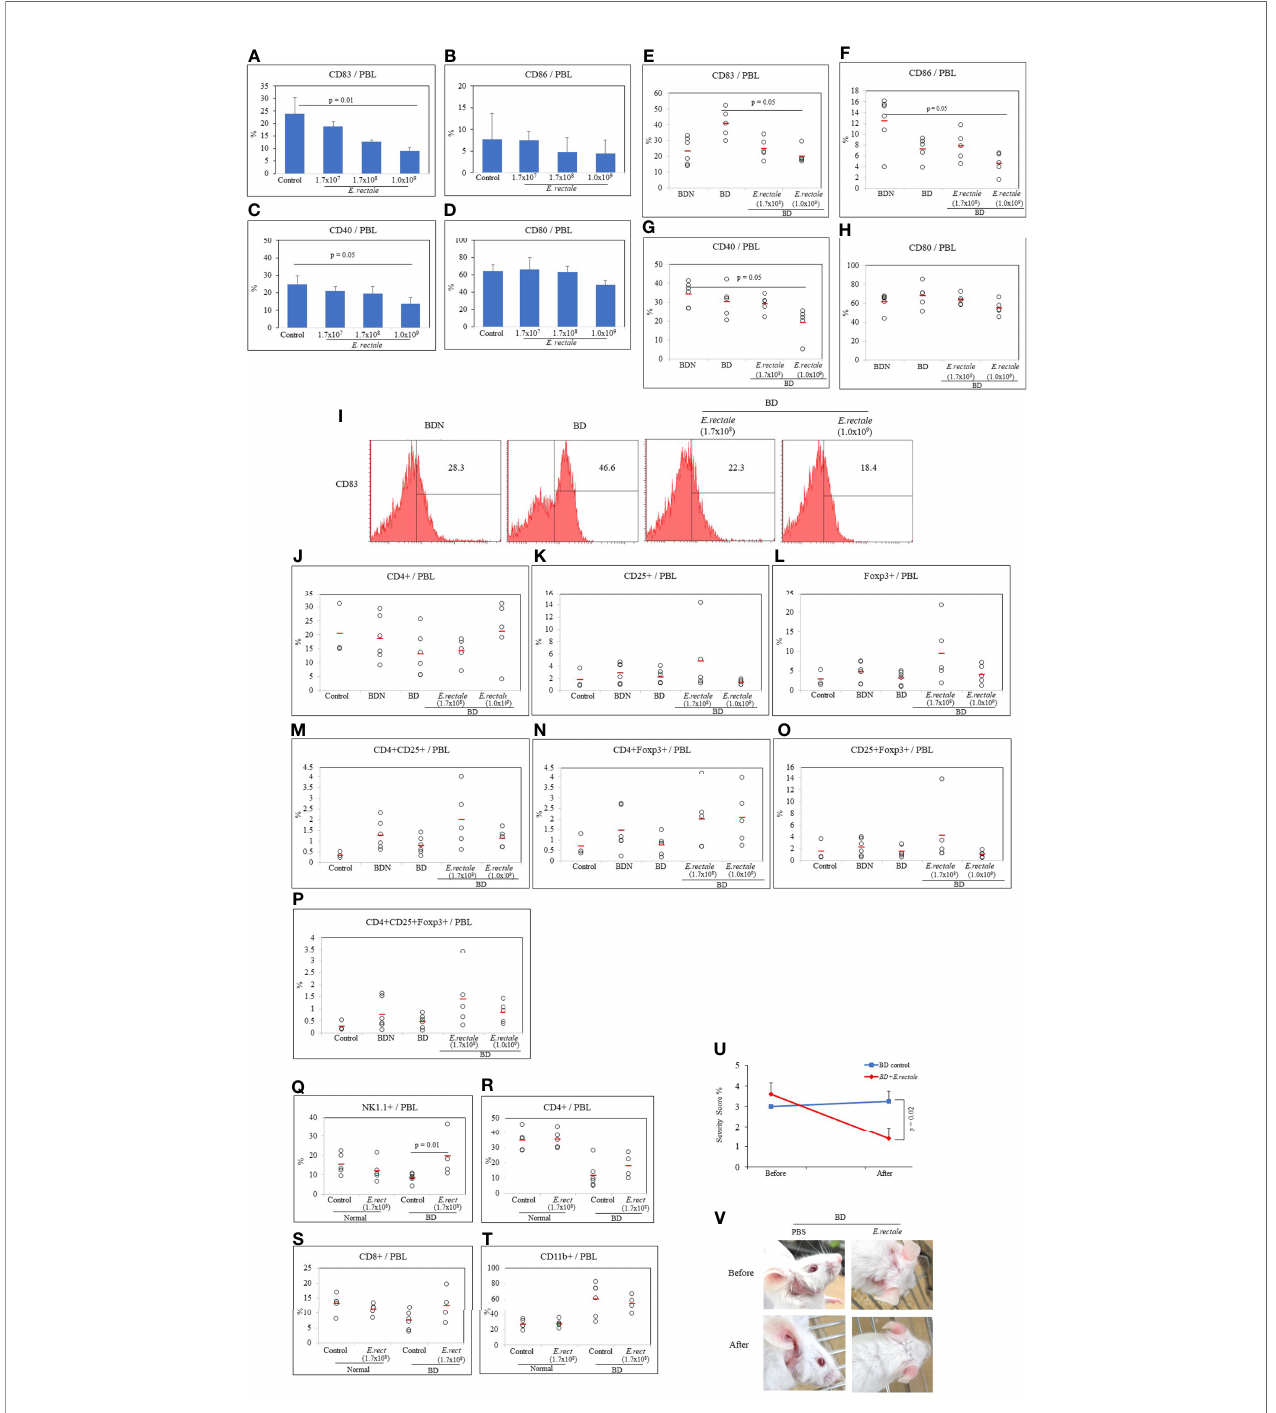
FIGURE 6 | Eubacterium rectale administration regulated dendritic cell activation and regulatory T cells in normal mice. The frequencies of CD83, CD86, CD40 and CD80 on the PBL surface of normal mice treated with E. rectale (1.7x107, 1.7x108, 1.0x109 CFU) for 10 consecutive days were evaluated by fl ow cytometry (A – D) . The frequencies of CD83, CD86, CD40 and CD80 on the surface of the PBL of BD mice treated with E. rectale (1.7x108 and 1.0x109 C.F.U) were assessed by fl ow cytometry (E – H) . Representative histograms of the frequency of CD83+ in PBL of BD mice (I) . The frequency of regulatory T cells was analyzed by FACS in normal control, BDN, BD and BD mice treated with E. rectale (J – P) . The frequencies of NK1.1+, CD4+, CD8+ and CD11b+ cells in normal, E. rectale -treated normal, BD and E. rectale -treated BD mice were evaluated by FACS analysis (Q – T) . Administration of E. rectale (1.7x108) for 10 consecutive days signi fi cantly reduced the severity score (U) and improved symptoms (V) in BD mice. Experiments were performed independently at least three times. The p-value was determined by the Kruskal-Wallis